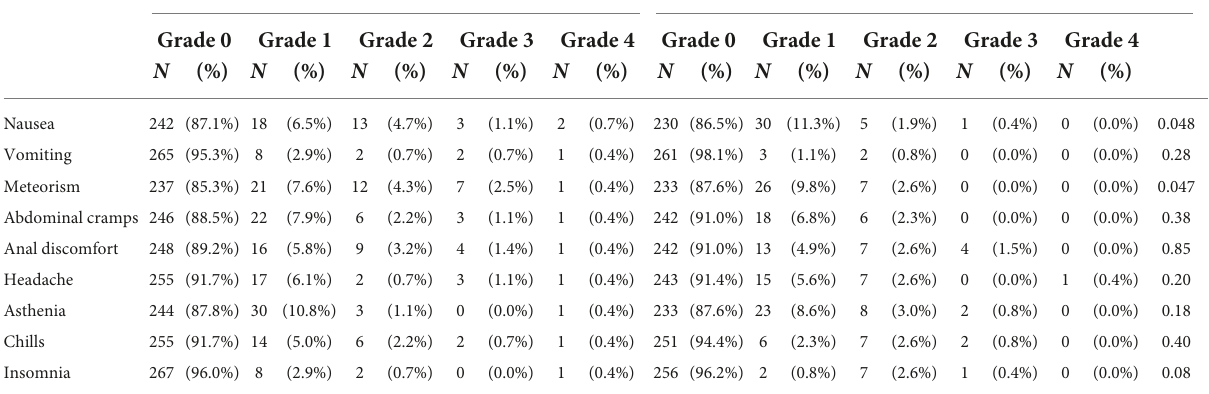
TABLE 4 Side effects of bowel preparation.